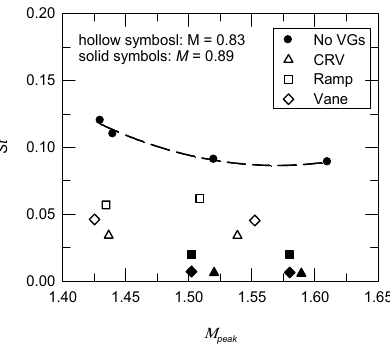
Figure 17. St with/without MVGs.